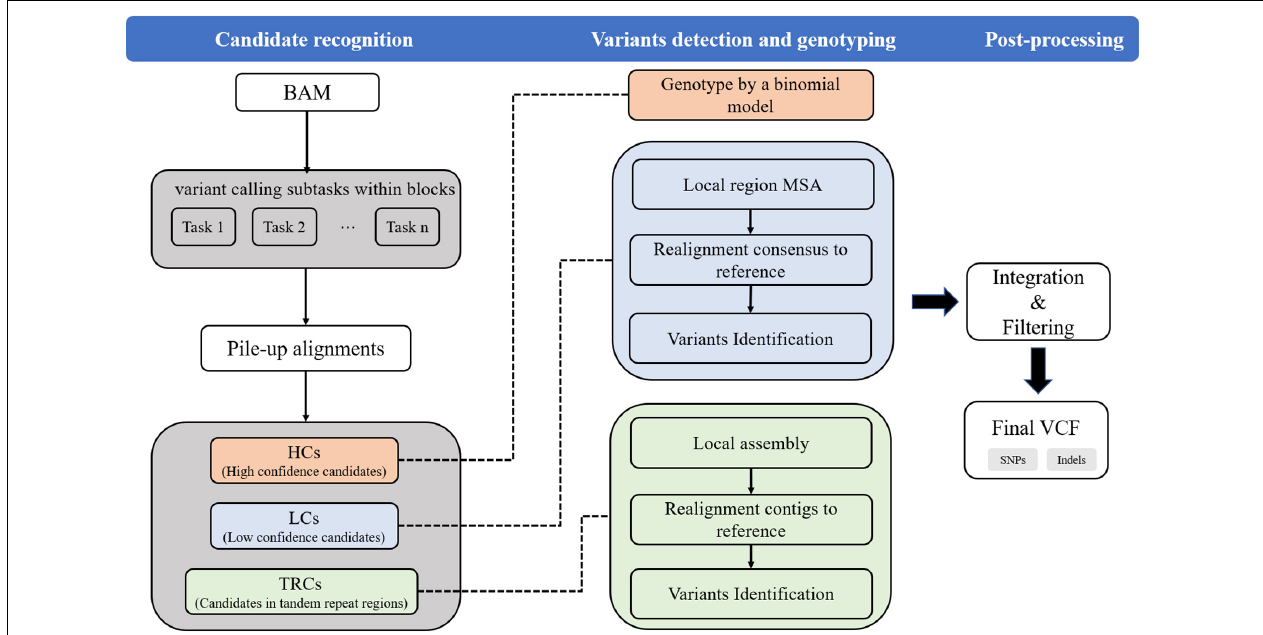
FIGURE 1 | The workflow of Psi-caller approach. Psi-caller detects SNV/Indels mainly in three steps. In step 1 (“Candidate recognition”), Psi-caller first generates multiple tasks according to chromosome and block size for parallelization and then extract candidate variant site separately for each task. In step 2 (“Variants detection and genotyping”), Psi-caller implements three difference approaches to generate variant calls and assigns genotypes. In step 3 (“Post-processing”), Psi-caller concatenates the resulting output from various tasks and removes duplicated